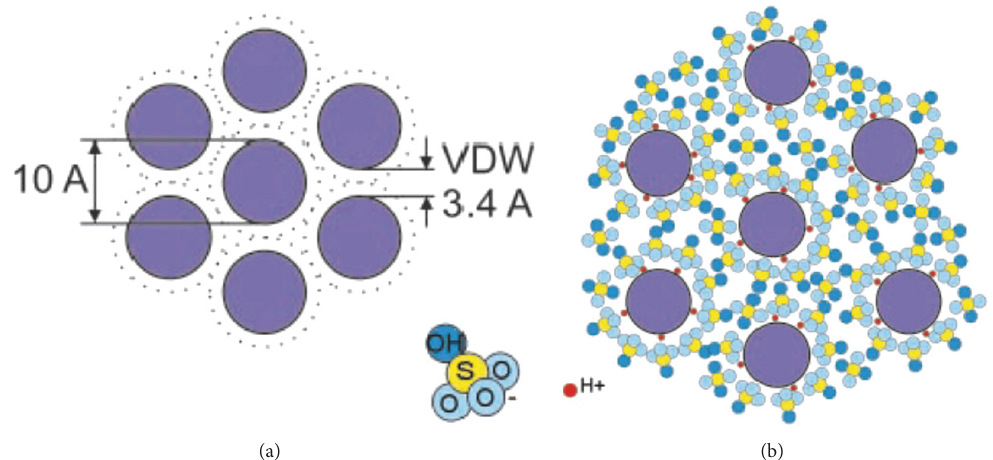
Figure 9: Mechanism of CNT fiber formation. (a) SWNTs in van der Waals contact. (b) SWNT ropes after exposure to sulfuric acid [32]. Reprinted from